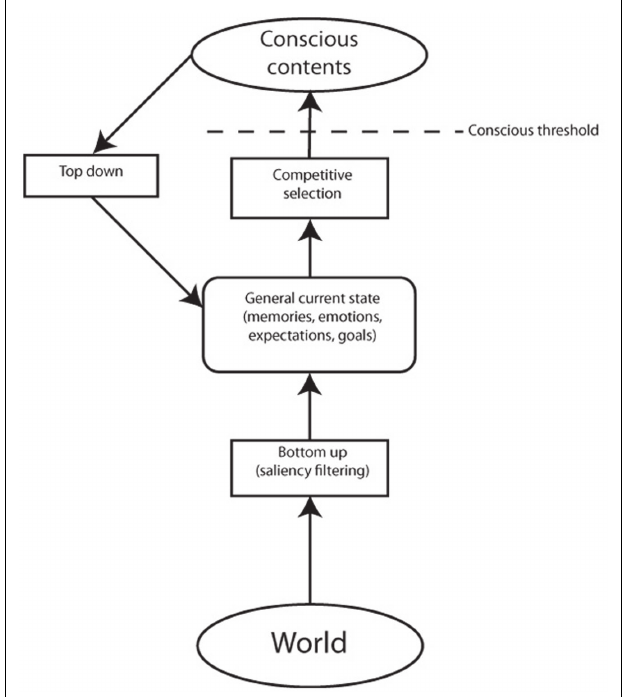
FIGURE 2 |Adaptation of model of attention as formulated by Knudsen (2007) to incorporate consciousness. Bottom-up attention initially processes sensory input according to low level and biologically salient filters.This data is then compared with long-term memory representations, current goals, and other internal states, in order to assign weightings for an attentional competitive selection process.The result of this process leads to the strongest signals being favorably activated, with others inhibited. Those items gaining sufficient excitation will enter consciousness. Conscious contents, which are maintained in working memory in the model, can also be influenced by a recurrent loop with top-down attention biasing weightings for competitive selection. According to this model, it is possible for both top-down and bottom-up attention to occur for unconscious items (for instance by modulating expectations without the object of those expectations having sufficient strength in the subsequent competitive selection process to reach consciousness). However, conscious access for a given object is only possible following an attentional competitive selection process, which can be modulated by top-down and/or bottom-up